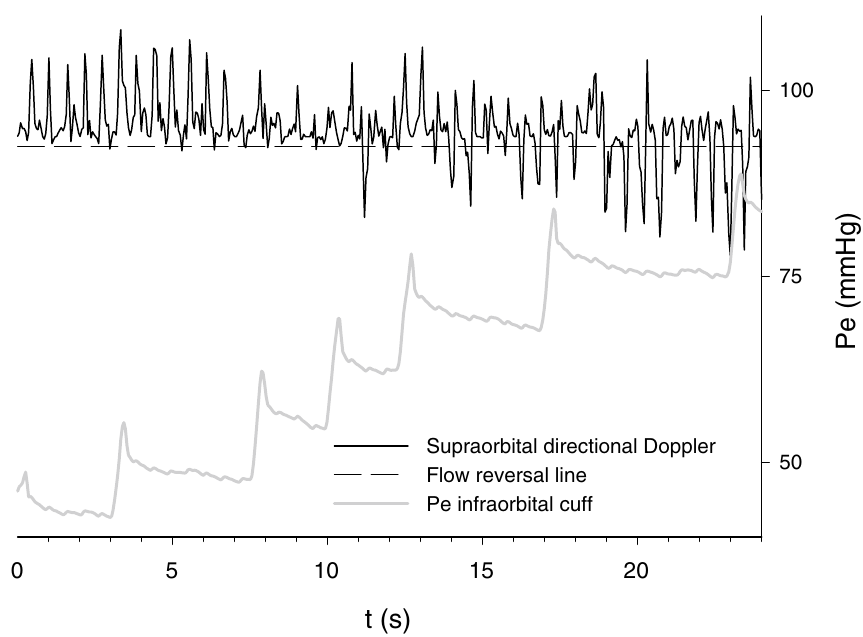
Figure 4. Reversal of the intra-extracranial steal in the supraorbital artery. Directional Doppler examination of the supraorbital artery in a healthy volunteer demonstrates that antegrade (intra-extracranial flow) via this intra- extracranial collateral reverses during step-wise infraorbital cuff inflation: as extracranial outflow pressure, Pe increases. Characteristic oscillations are visible in the infraorbital cuff due to the transmission of the pulse from the facial and temporal arteries (branches of the external